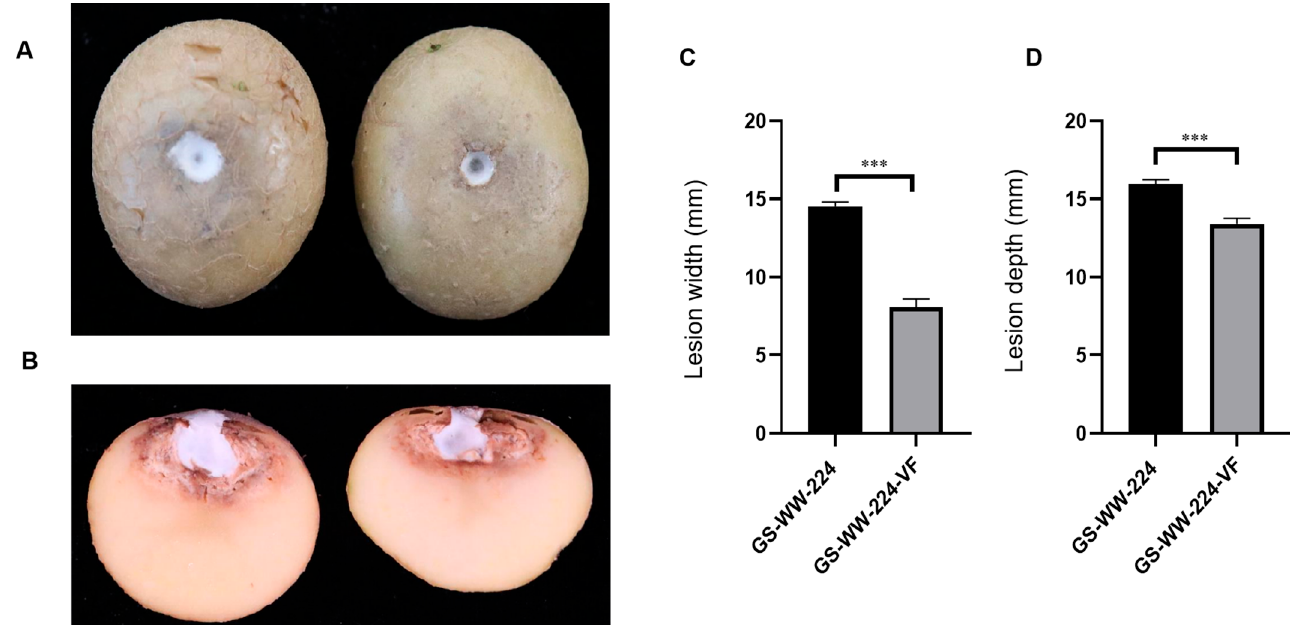
Figure 4. Virulence of Fusarium avenaceum strains GS-WW-224 and GS-WW-224-VF on potato tubers. ( A ) Representative photograph of dry rot symptoms caused by strains GS-WW-224 (on the left) and GS-WW-224-VF (on the right) on potato tubers at seven days post inoculation. ( B ) Representative photograph of a longitudinal section through a dry rot lesion caused by strains GS-WW-224 (on the left) and GS-WW-224-VF (on the right) on potato tubers. ( C ) Width of lesions on potato tubers infected by strains GS-WW-224 and GS-WW-224-VF. ( D ) Depth of lesions on potato tubers infected by strains GS-WW-224 and GS-WW-224-VF. Asterisks indicate different levels of significant difference (*** p < 0.001) between the two strains as determined by paired t-test using GraphPad Prism version 8.0 software.